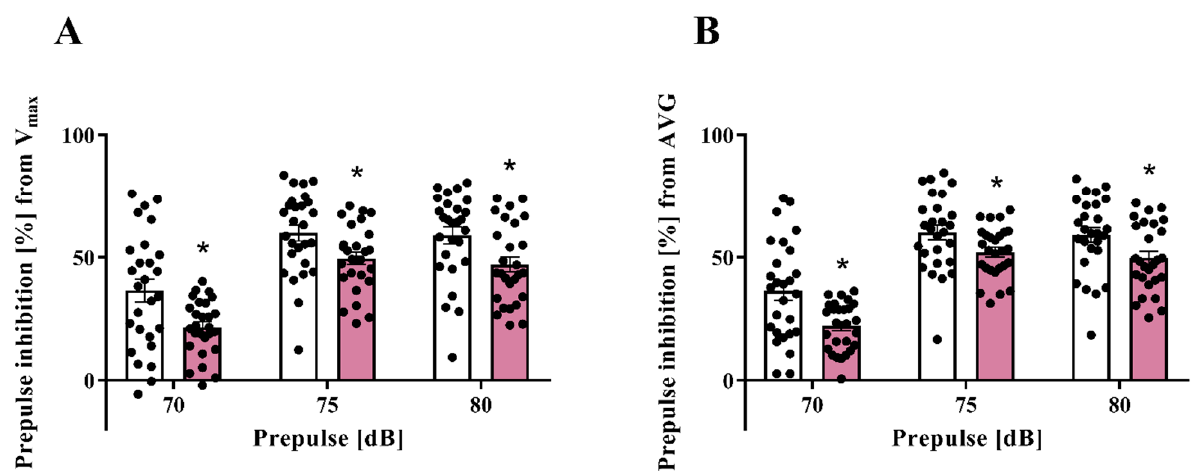
Figure 1. Representative prepulse inhibition (PPI) of the acoustic startle response in the control and prenatally LPS-exposed offspring at PND90 ( n = 27 in each group). The results are presented as the means of the percentage of PPI (%PPI) calculated from the maximum startle response (V max ) ( A ) and average startle amplitude (AVG) ( B ) induced by each prepulse intensity ± SEM. * p < 0.05 vs. control group.